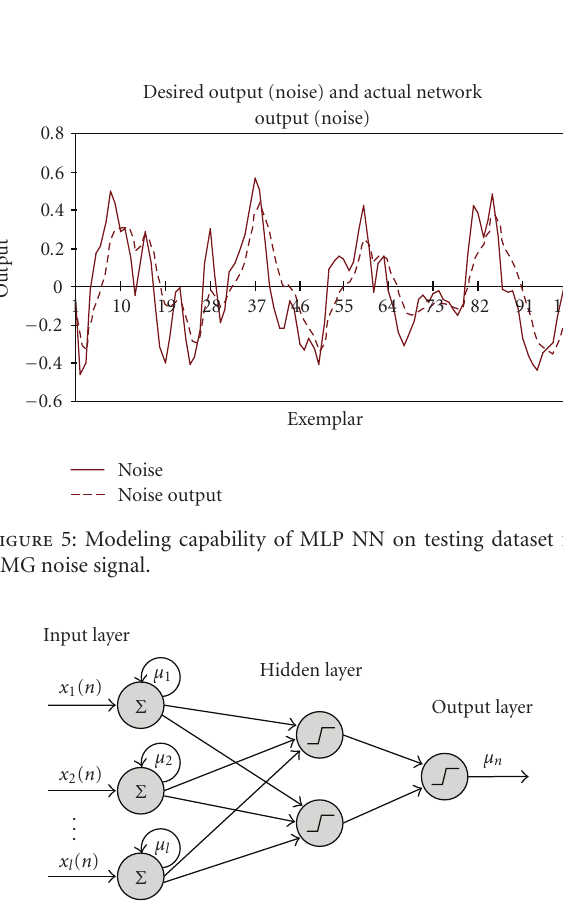
Figure 6: MLP with an input layer of context PEs (focused architecture). Table 4: Number of hidden layers and r